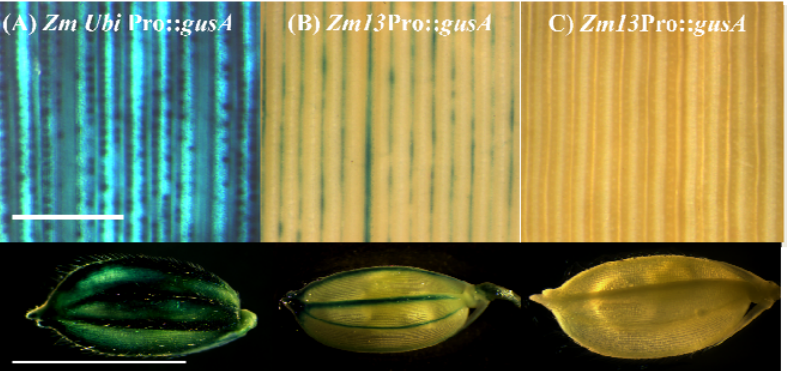
Figure 7. GUS activity in transgenic events. Adult leaves are shown in the top panel, mature flowers shown in the bottom panel. ( A ) GUS positive pOsUbiPro::GUS control shows strong activity in all observed tissues and organs; ( B ) p Zm13 Pro::GUS T showing ectopic expression in mature vascular tissue in leaves and floral